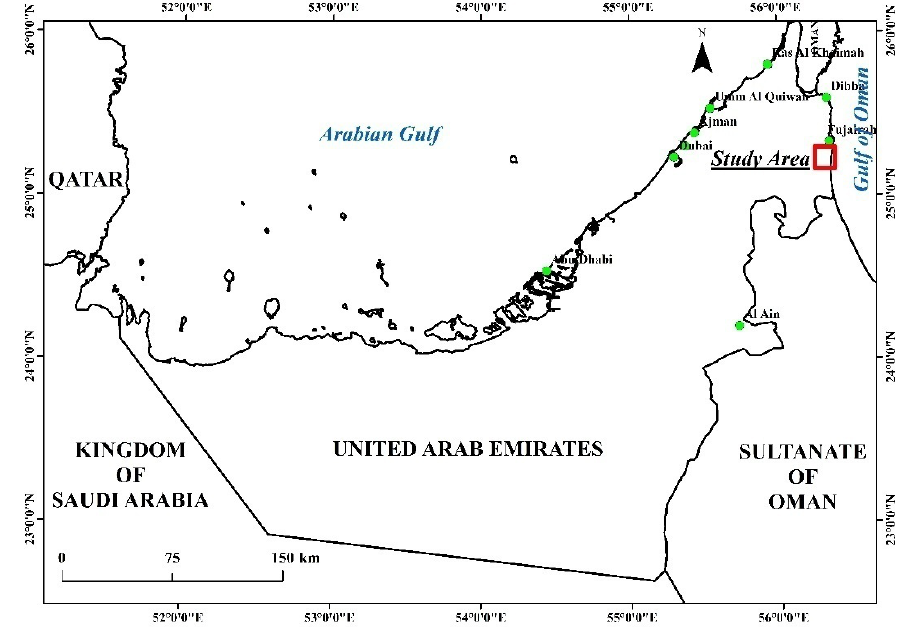
Figure 1. Location map of the United Arab Emirates and study area (bounded by red rectangle).